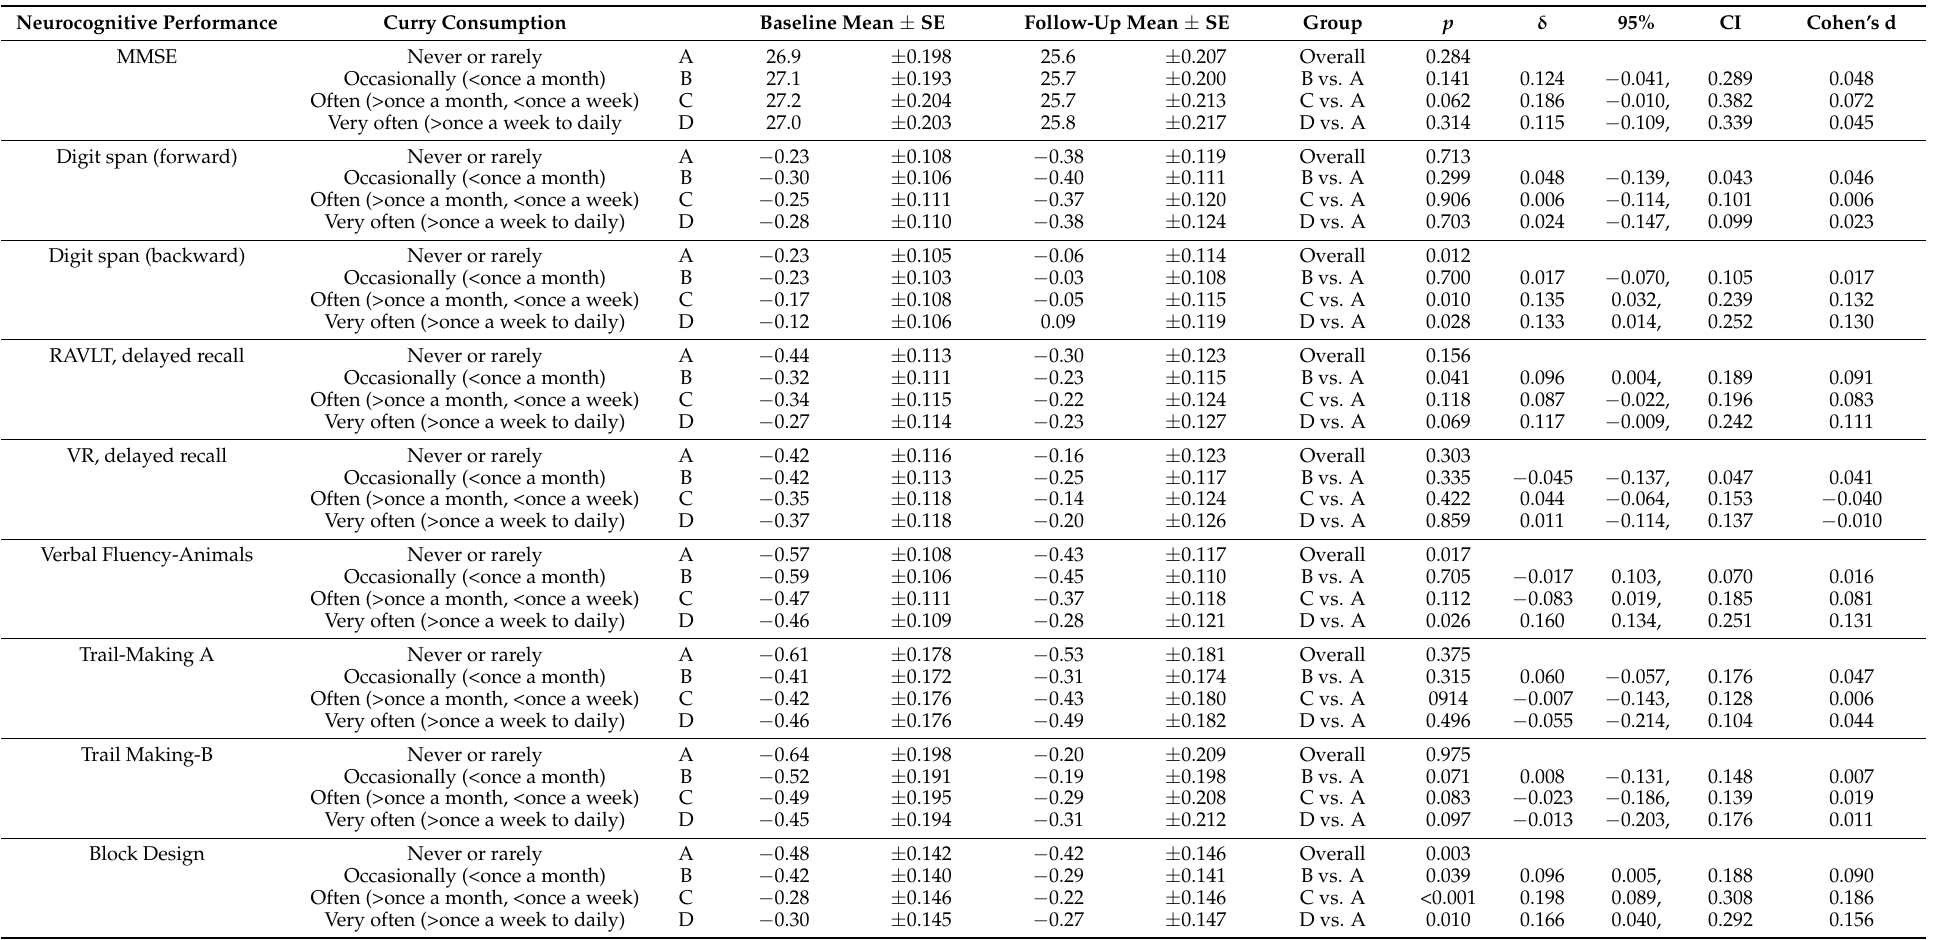
Table 3. Mixed linear model analyses: covariate-adjusted mean neurocognitive z-scores at baseline and follow-up by curry consumption. Neurocognitive